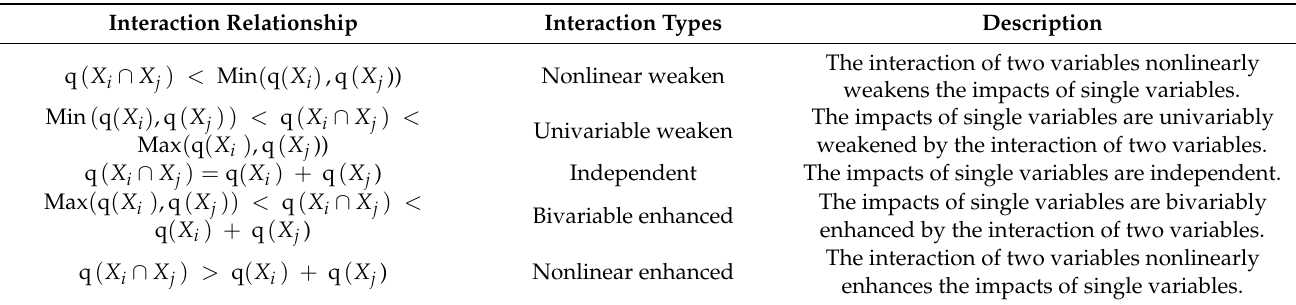
Table 2. Definition of the interaction types in the GeoDetector model. Interaction Relationship Interaction Types Description weakens the impacts of single